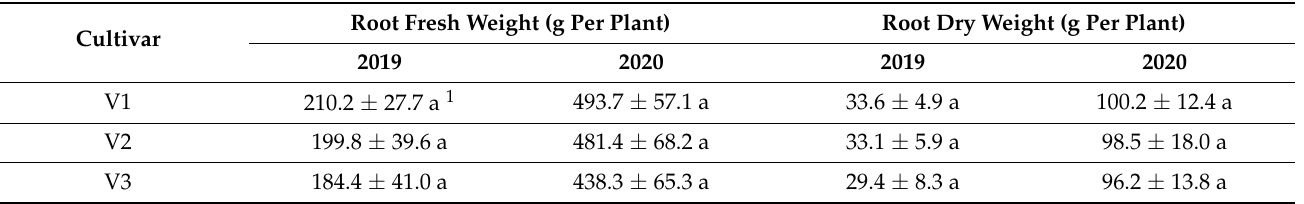
Table 3. Root fresh weight and dry weight of three danshen cultivars grown in Mississippi, United States in 2019 and 2020.